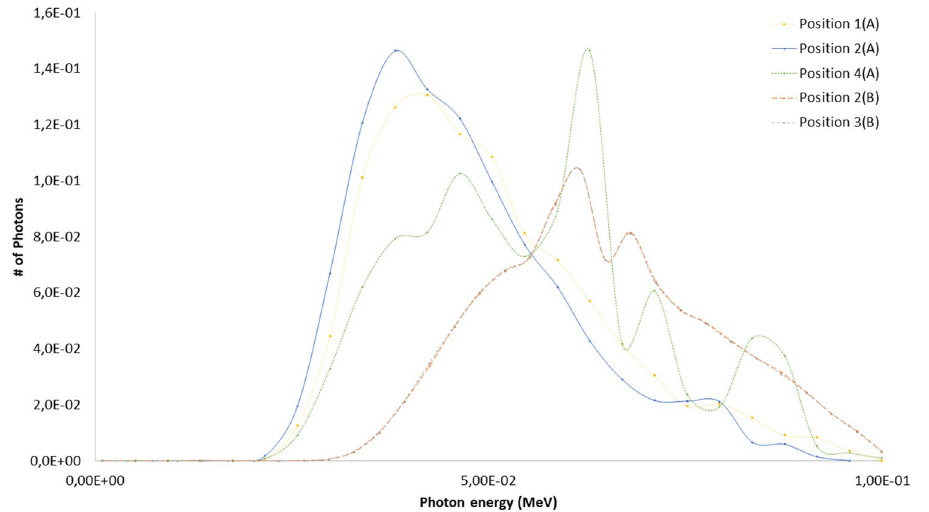
Figure 9. Scenario A and B spectral comparison at the various Petri dishes as estimated with MCNP (see Fig. 2, and Tables 1, 2, 3, 4, 5 for details). Photon energy scale in